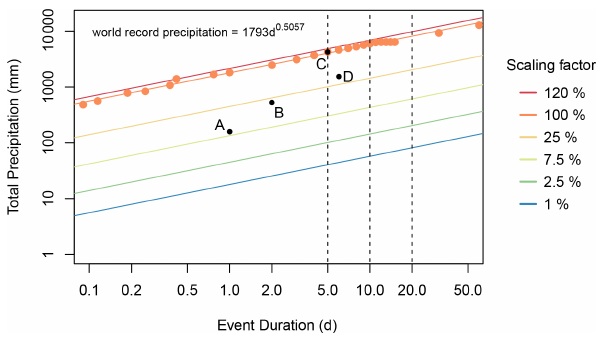
Figure 3. Synthetic IDF (intensity, duration, and frequency) curves along which synthetic forcing data were generated, where the ver- tical black lines show the precipitation event durations used. The IDF curves are interpolated between world record events for given durations, scaled by 6 different factors, ranging from 0.01 to 1.2, indicated by color. The precipitation world records are World Mete- orological Organization data (World Meteorological Organization, 1994) and are indicated by orange points. The power function giv- ing the best fit for the world records is shown. Black points are real events which are described here in order to give further con- text for the IDF curves. (a) The largest precipitation ever recorded in the Netherlands in a 24h period (Brauer et al., 2011). (b) An at- mospheric river event in Sonoma County, California, USA, in late February 2019 (NOAA, 2019; Ralph et al., 2020). (c) Cyclone Hy- acinthe (World Meteorological Organization, 1994). (d) Hurricane Harvey near Nederland, Texas, USA (Blake and Zelinsky,